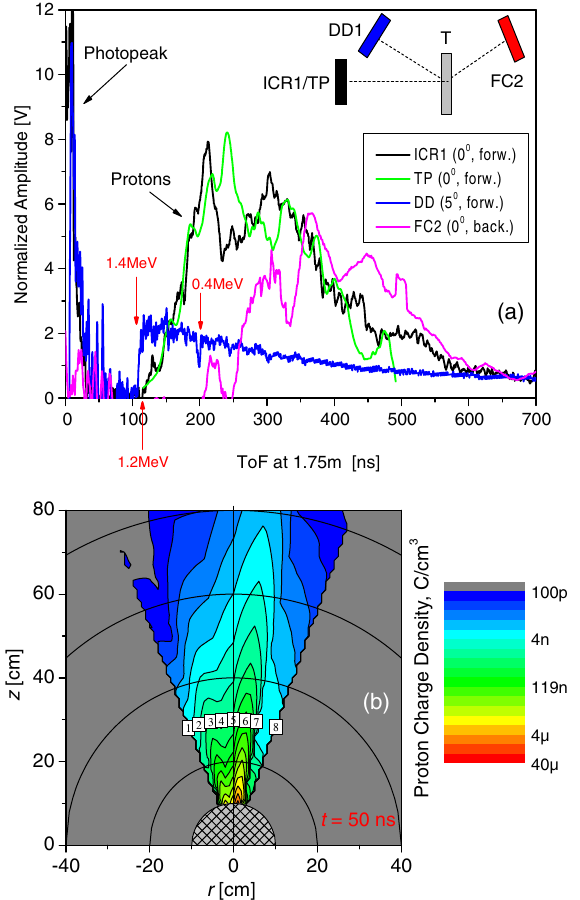
FIG. 6. (a) Normalized TOF signal for the different ion detectors (ICR1, TP, DD1, FC2) used during the same laser shot. (b) Proton angular distribution reconstructed from the eight FCs placed in the forward direction (shown as white squares).